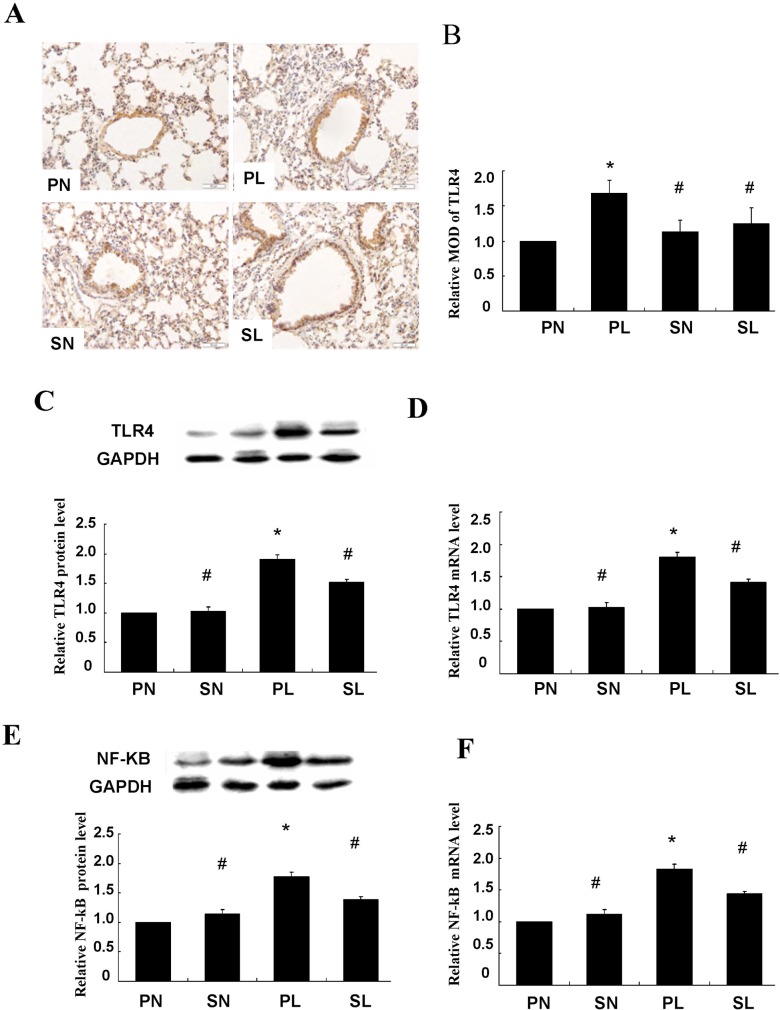
Immunohistochemical staining of TLR4 in trachea and effects of sevoflurane on TLR4 protein and mRNA expression after LPS challenge in vivo.(A) Representative micrographs of TLR4 in trachea of mice anesthetized with phenobarbital or sevoflurane in absence or presence of LPS challenge. The presence of TLR4 was observed only in the smooth muscle cell layer, whose cell membrane and cytoplasm stained tan as detected by horseradish peroxidase–labeled antibodies. Scale bars = 50 μm. (B) Histogram for quantification of TLR4 in smooth muscle cell layer. The mean optical density values (MOD) were calculated after normalizing against PN. (C) Representative western blot and quantitative analysis of TLR4 isolated from smooth muscle cell layer after LPS challenge. (D) Quantitative real-time PCR of TLR4 mRNA expressions in isolated smooth muscle cell layer. (E) Representative western blot and quantitative protein analysis of NF-κB in nuclear extracts from smooth muscle cell layer after LPS challenge. (F) Quantitative real-time PCR of NF-κB mRNA expressions in smooth muscle cell layer after LPS challenge. Sevoflurane prevented significant increases in protein and mRNA expressions of TLR4 and NF-κB in isolated smooth muscle cell layer from mice after LPS challenge. The relative integral density values (IDVs) were calculated after normalizing against GAPDH in each sample and presented as relative protein expression units. Data are presented as means ± SEM (n = 8 per group). *P < 0.05 versus PN; #P < 0.05, versus PL.